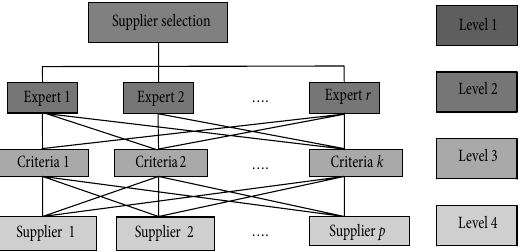
Fig. 1. Hierarchic system of problem – supplier